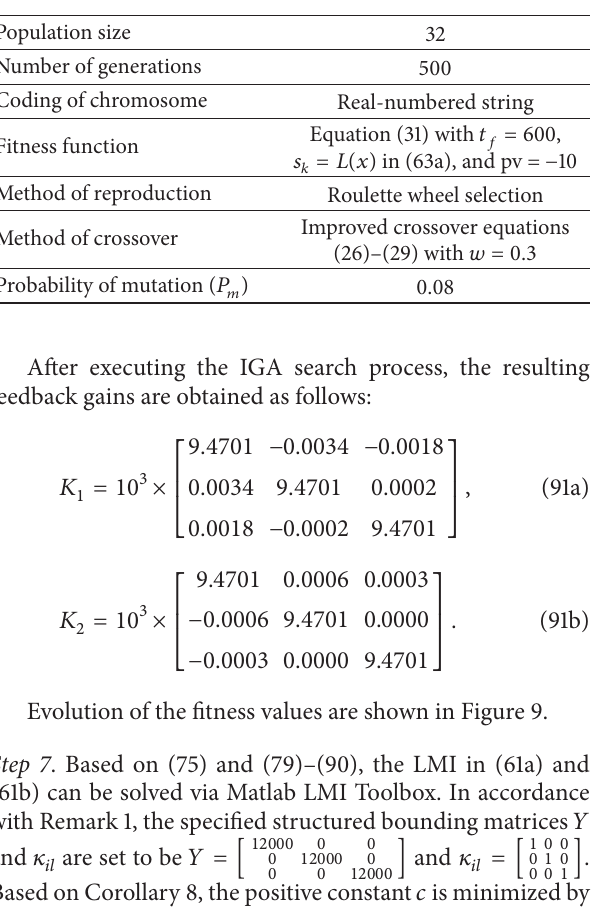
̇̂𝑋(𝑡) for original system and NN model. Table 1: Specifications for